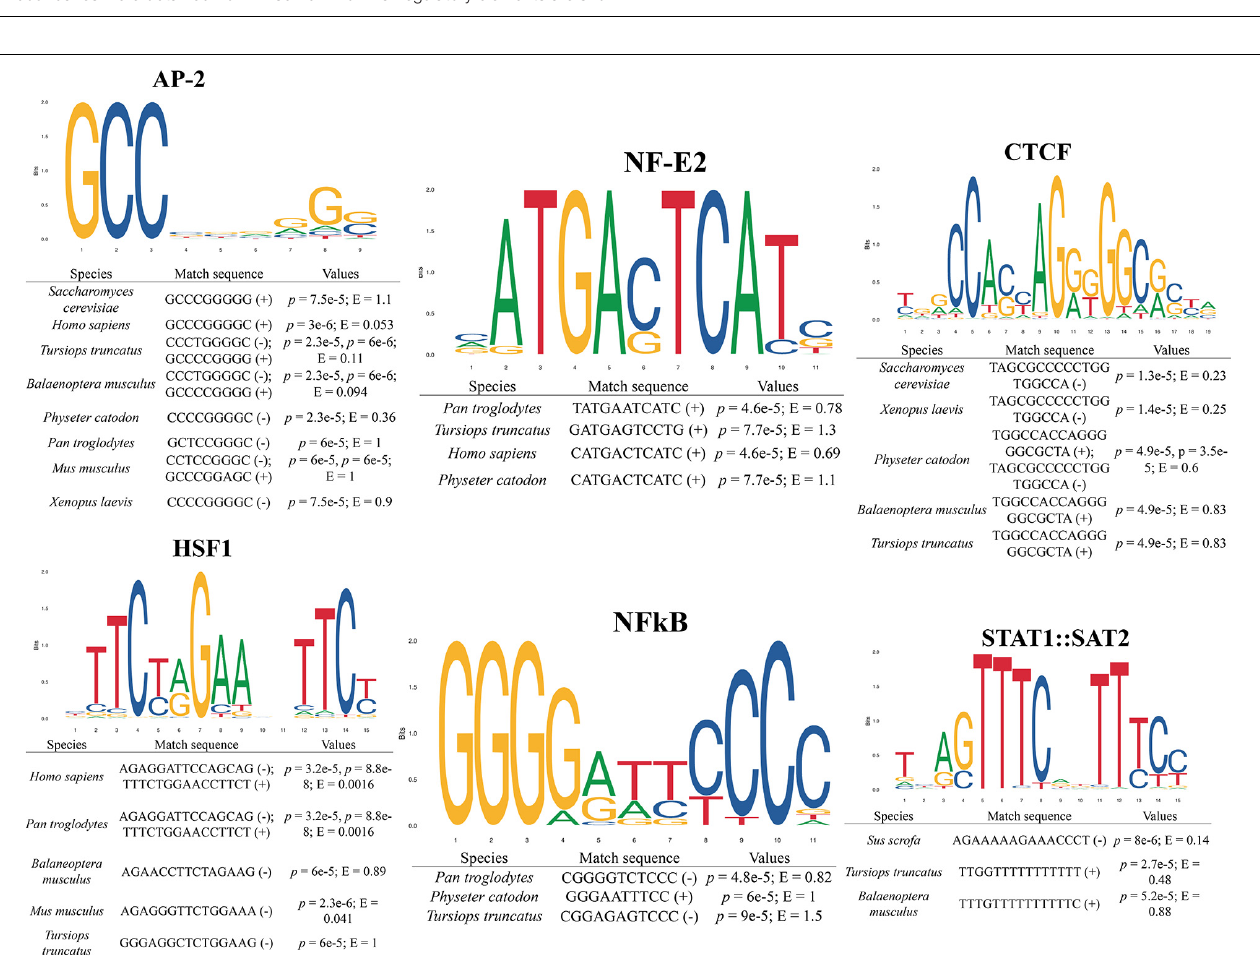
FIGURE 2 | Binding site prediction for transcription factors in the promoter region of distinct taxa heme oxygenase 1 gene ( hmox1 ). E -values and prediction p -values are shown. (+) and (–) indicate forward and reverse strand, respectively.